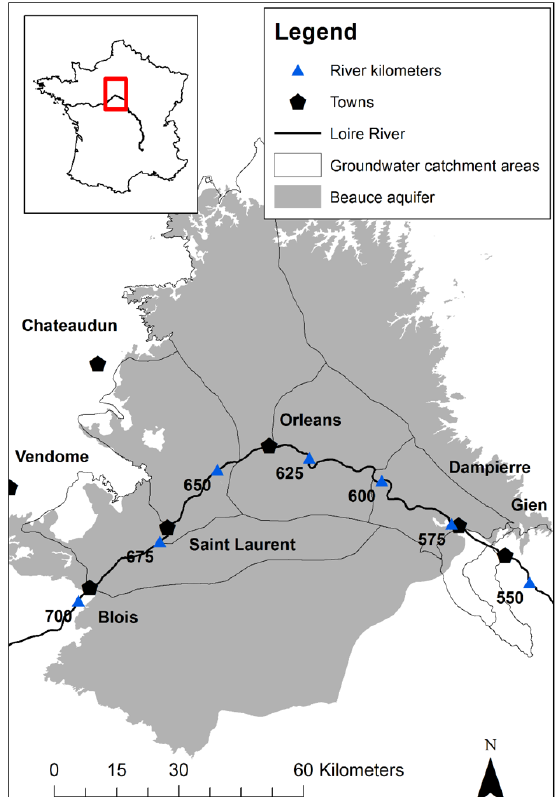
Figure 1. Map of the study area. The delineation of the Beauce aquifer comes from the BDLISA database from the Bureau de Recherches Géologiques et Minières